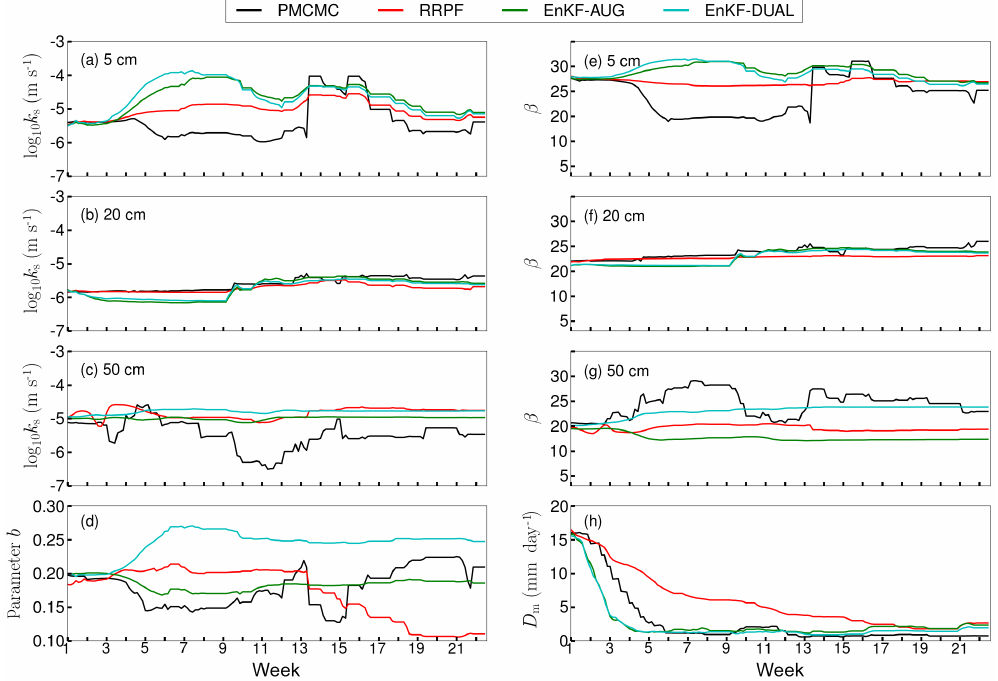
Figure 4. Trace plots (solid lines) of VIC-3L parameters. Saturated hydraulic conductivity (log 10 k s in ms − 1 ) at (a) 5cm, (b) 20cm, and (c) 50cm depths, (d) b , β at (e) 5cm, (f) 20cm, and (g) 50cm depths, and (h) the maximum baseflow velocity, D m , in mmday − 1 during the 5-month assimilation period. Color coding is used to differentiate between the results of PMCMC (black), RRPF (red), EnKF-AUG (green), and EnKF-DUAL (cyan). The first days of weeks 1 and 22 are 1 March and 26 July 2012, respectively.